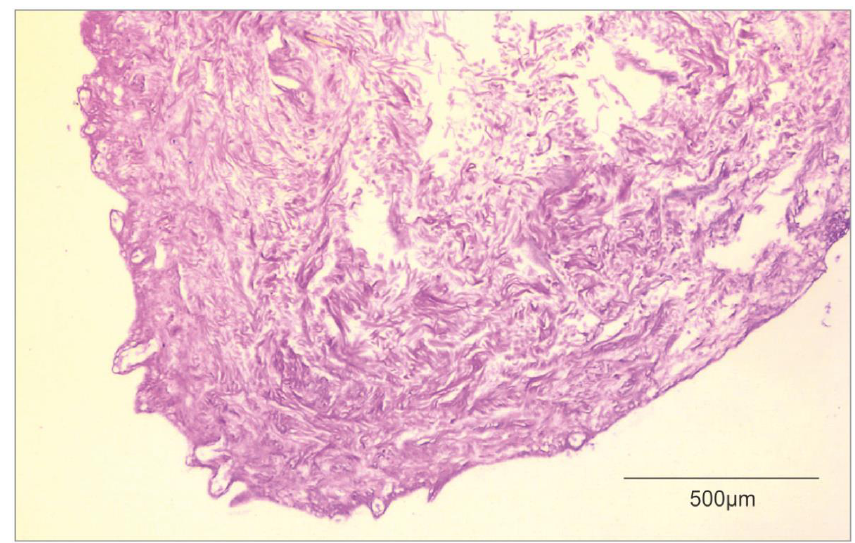
Figure 3. Histological image of ADM (own material).